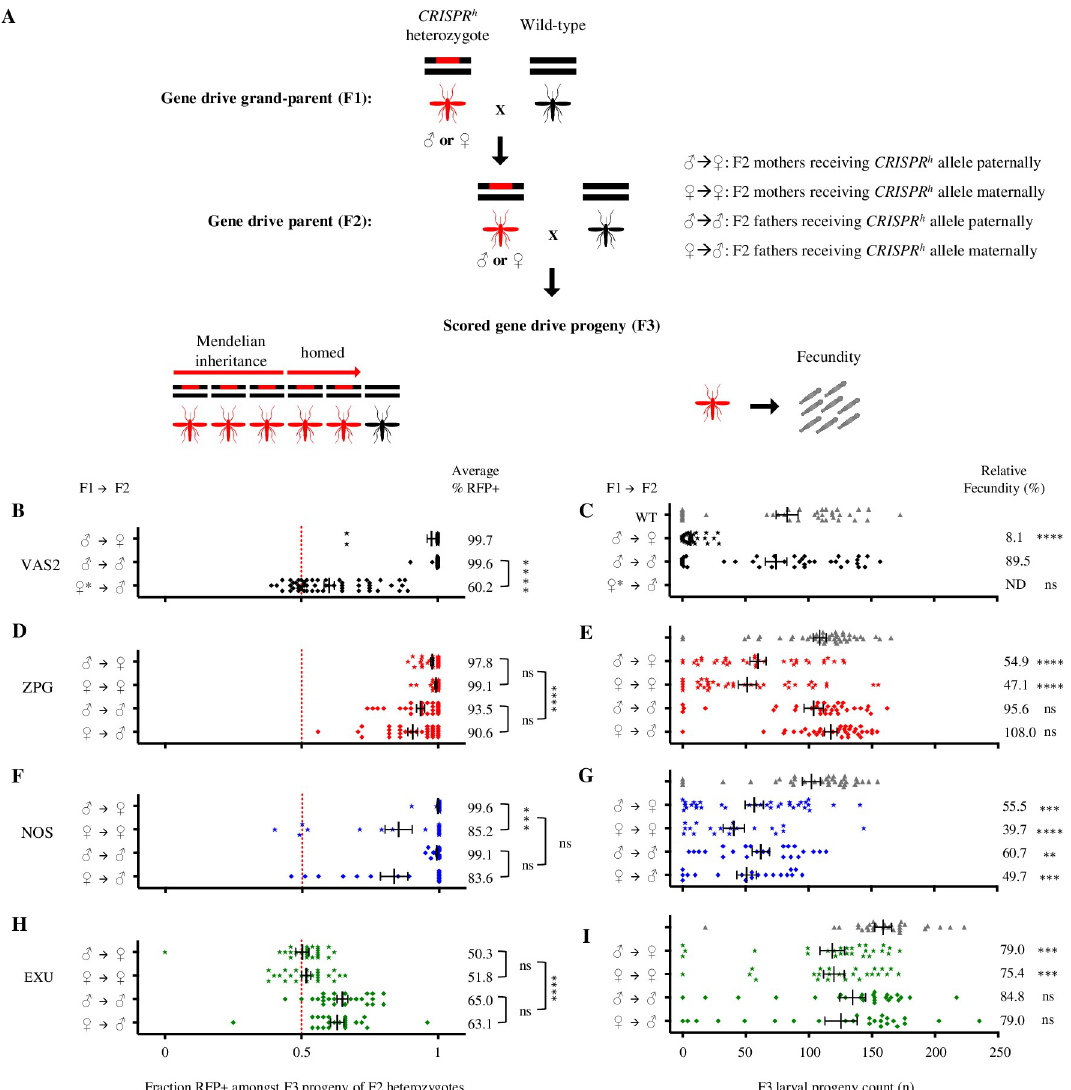
Fig 2. Comparison of fecundity and homing rates in mosquitoes containing Cas9-based gene drives under regulation of zpg , nos and exu germline promoters. Phenotypic assays were performed to measure fecundity and transmission rates for each of three drives. CRISPR h heterozygotes of both sexes were crossed to wild type (panel A, F1) and their CRISPR h heterozygous progeny were subsequently also crossed to wild type (A, F2). The larval progeny (F3) of the F2 cross were counted to determine the fecundity of CRISPR h heterozygotes (F2), depending on whether they inherited the gene drive from male or female parents (F1) (A right, C, E, G, I). The larval progeny (F3) were also scored for the presence of DsRed linked to the construct to determine gene drive transmission rates of CRISPR h heterozygotes (F2), depending on whether they inherited the gene drive from male or female parents (F1) (A left, B, D, F, H). Each data point represents one clutch from one individual F2 female. Average transmission rates are shown on the right of panels B, D, F, H (Mann-Whitney test, ���� : p < 0.0001, ��� : p < 0.001, � : p < 0.05, ns: non-significant), and relative fecundity to wild type is depicted on the right of panels C, E, G, I (Kruskal-Wallis test, ���� : p < 0.0001, ��� : p < 0.001, �� : p < 0.01, ns: non-significant). Males and females were further separated by whether they had inherited the CRISPR h construct from either a male or female parent (Mann-Whitney test, ���� : p < 0.0001, ��� : p < 0.001, � : p < 0.05, ns: non-significant). For example, ♂ ! ♀ denotes the progeny count and gene drive transmission rates in the progeny of a heterozygous CRISPR h female that had inherited the drive allele from a heterozygous CRISPR h male, when crossed to a wild-type male. High levels of homing were observed in the germline of zpg-CRISPR h and nos-CRISPR h males and females, however the exu promoter generated only moderate levels of homing in the germline of males but not females (Mann-Whitney test, p < 0.0001). The significant maternal effect upon homing performance in offspring previously seen for vas2-CRISPR h (Hammond et al ., 2017, reproduced here in panel B) was also observed in nos-CRISPR h , but not for zpg- CRISPR h (Mann-Whitney test, ���� : p < 0.0001, �� : p < 0.001, � : p < 0.05, ns: non-significant). Counts of hatched larvae for the individual crosses revealed improvements in the fertility of heterozygous females containing CRISPR h alleles based upon zpg , nos and exu promoters compared to the vas2 promoter. Phenotypic assays were performed on G2 and G3 for zpg , G3 and G4 for nos , and